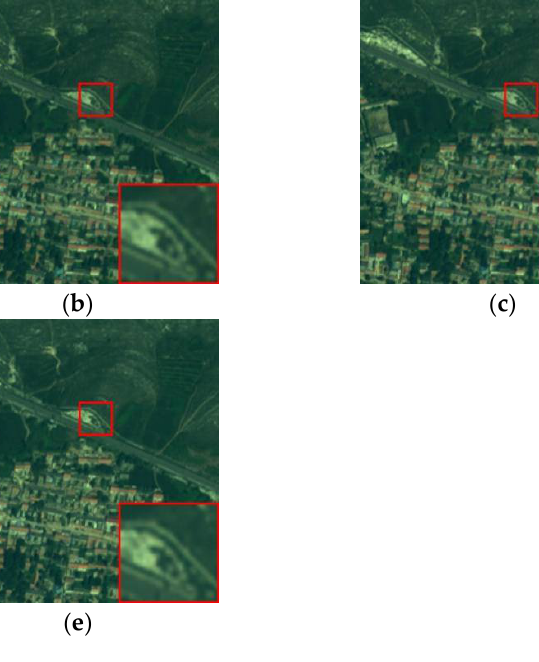
Figure 6. Fused image of WorldView-2. ( a ) Base line, ( b ) differential, ( c ) DenseNet, ( d ) differential + DenseNet, ( e ) differential + DenseNet + Hybrid Loss.